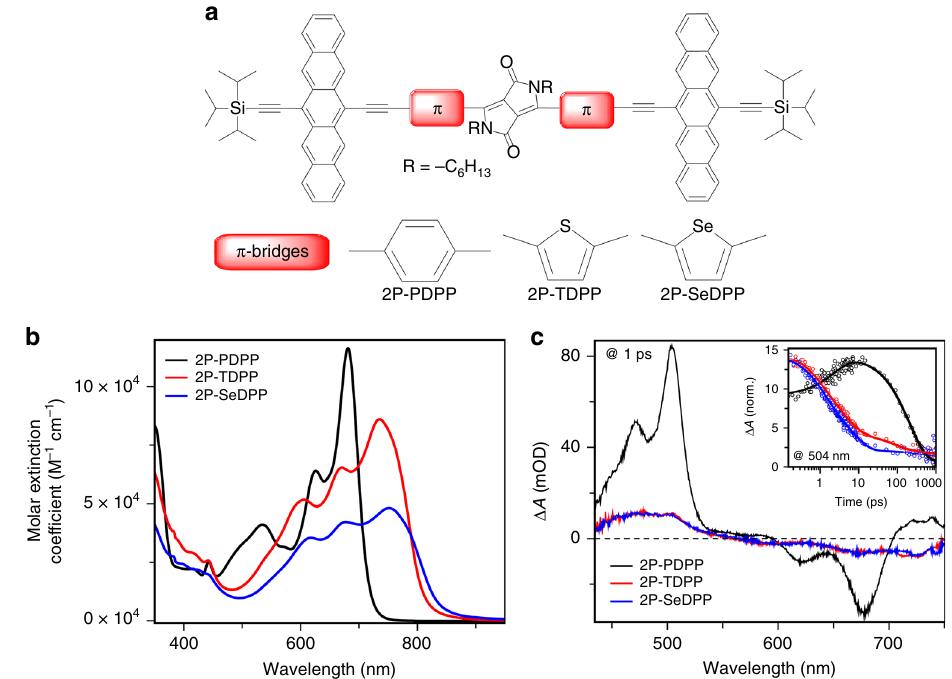
Fig. 1 Design of pentacene dimers and their optical properties. a Chemical structures of 2P-PDPP, 2P-TDPP and 2P-SeDPP. b Steady-state absorption spectra of the three molecules; and c their transient absorption spectra (TA) collected at 1 ps pump-probe delay. All three molecules were dissolved in chlorobenzene at 25 μ M concentration for the TA measurements, and excited using 0.1 mW pump pulses. For 2P-PDPP the excitation wavelength was 670 nm while it was 650 nm for both 2P-TDPP (red) and 2P-SeDPP (blue). Inset: Transient absorption kinetics taken at the photoinduced absorption peak at 504